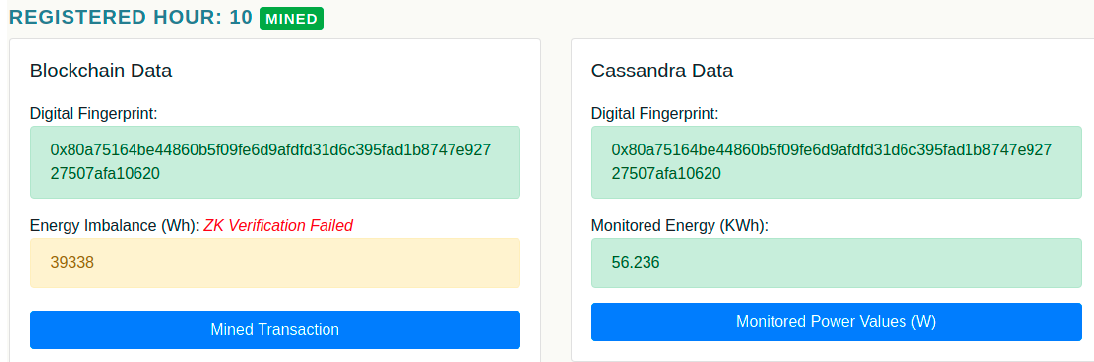
Figure 13. Inconsistency detected in the energy deviation registered on chain using the ZKP.